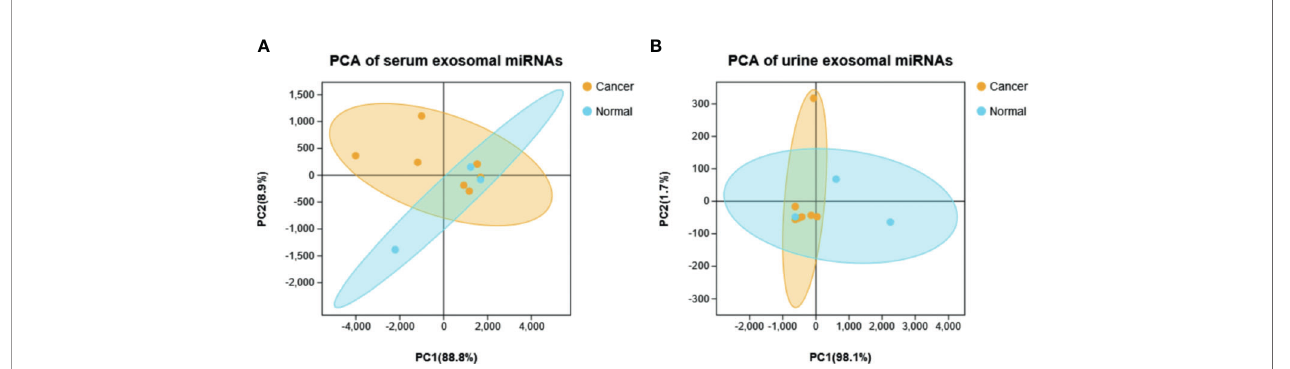
FIGURE 1 | The principal component analysis (PCA) based on all detected miRNA levels. (A) Serum. (B)